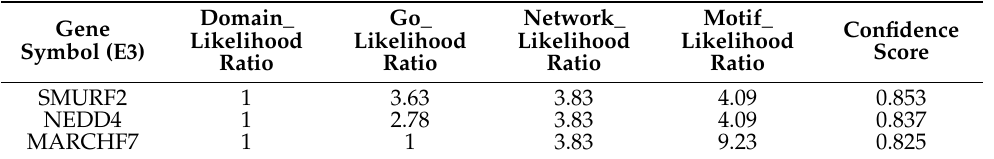
Table 3. Predicted E3s of OTUD5. (The UbiBrowser is a prediction and presentation website for E3/DUB-substrate interactions. By inputting the DUB of interest, the website will give the predicted substrate information and